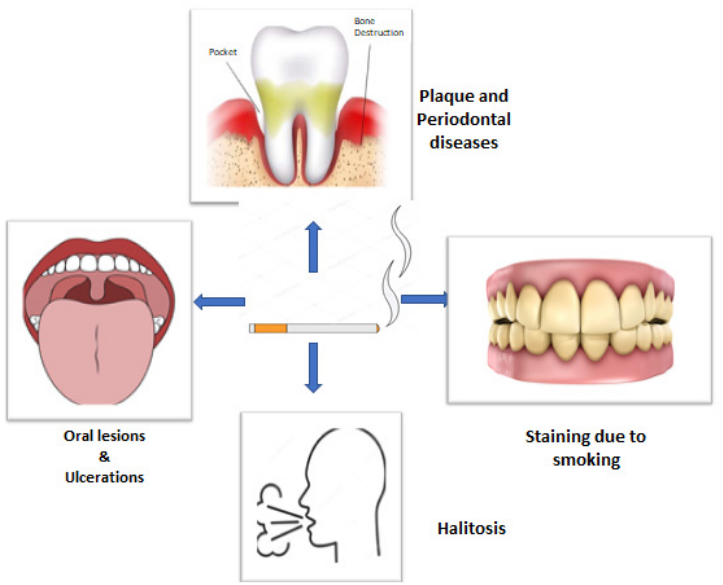
Figure 1. Diagrammatic presentation of possible effects of smoking on oral health.